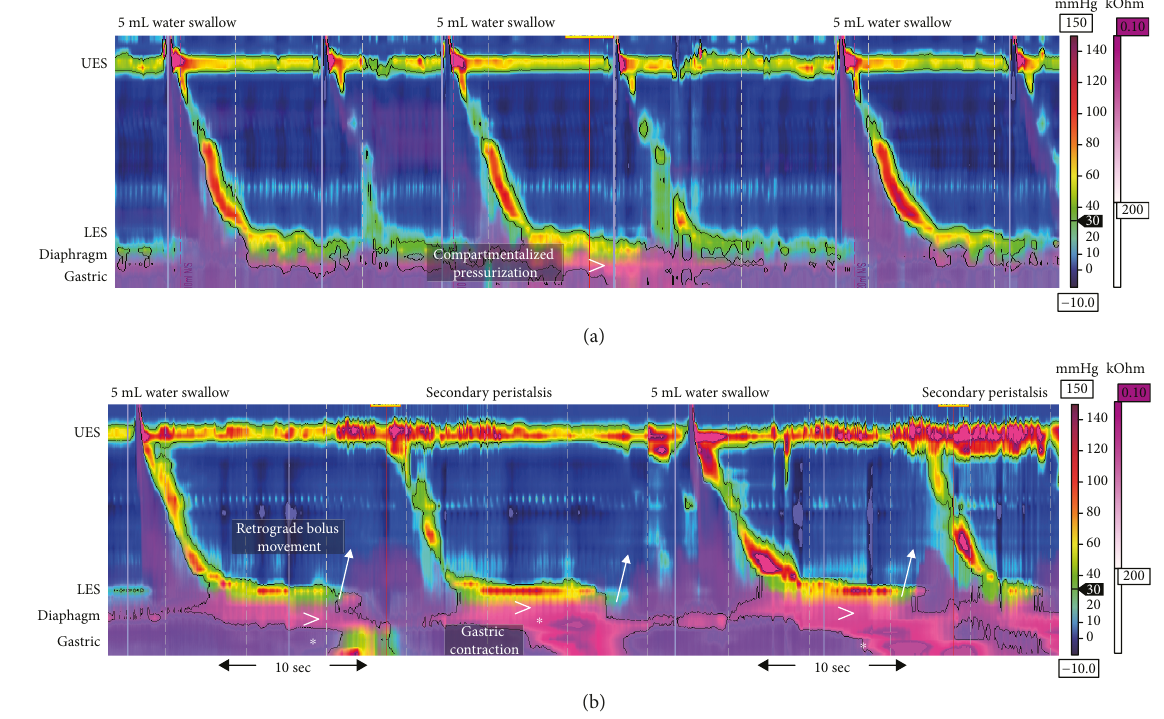
Figure 1: Examples of water swallows in post-LSG cases obtained with high-resolution impedance manometry at 30 mmHg isobaric contour. Impedance data are displayed by overlay pink colorization with the pink shading indicative of areas on the topography plots with bolus present. (a) An example of asymptomatic post-LSG peristaltic morphology. The 5 mL water swallows show intact peristalsis and complete bolus transit. A small amount of compartmentalized pressurization occurs at the hiatus hernia and propagates into the gastric sleeve (denoted by > ). (b) Swallow morphology of the case study showing normal peristalsis until at the contractile deceleration point where compartmentalized pressurization generates high-amplitude, long-duration contraction below the diaphragm (denoted by ∗ ). This contraction propagates further down into the gastric sleeve. The increase in intragastric pressure correlates with transient LES relaxation which results in the retrograde movement of gastric bolus (arrows highlight incidences of this retrograde movement). The presence of bolus in the esophagus triggers an involuntary secondary peristalsis to clear the distal esophagus. This process is repeated in the second 5mL water swallow. UES: upper esophageal sphincter; LES: lower esophageal sphincter.